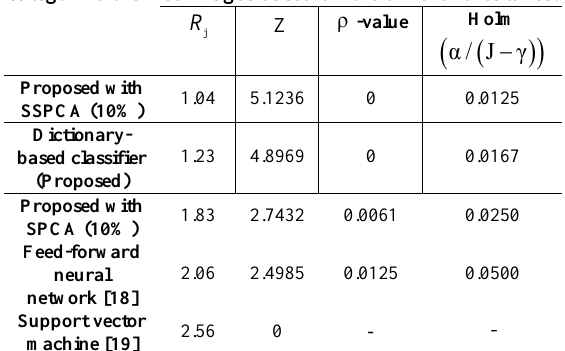
Table 8. Results of the statistical test to compare the performance of the neural network, support vector machine, and proposed dictionary-based classifier to categorize the rice images based on the different features.